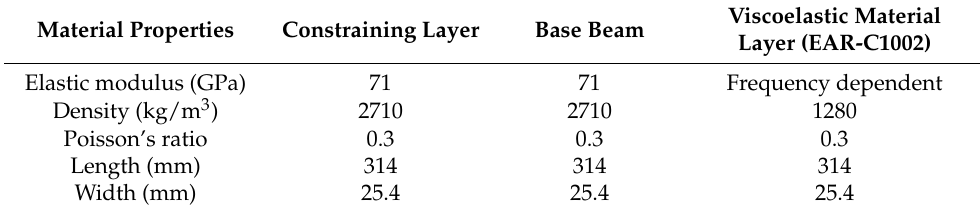
Table 3. Structure and material parameters of cantilever EVESbeams.